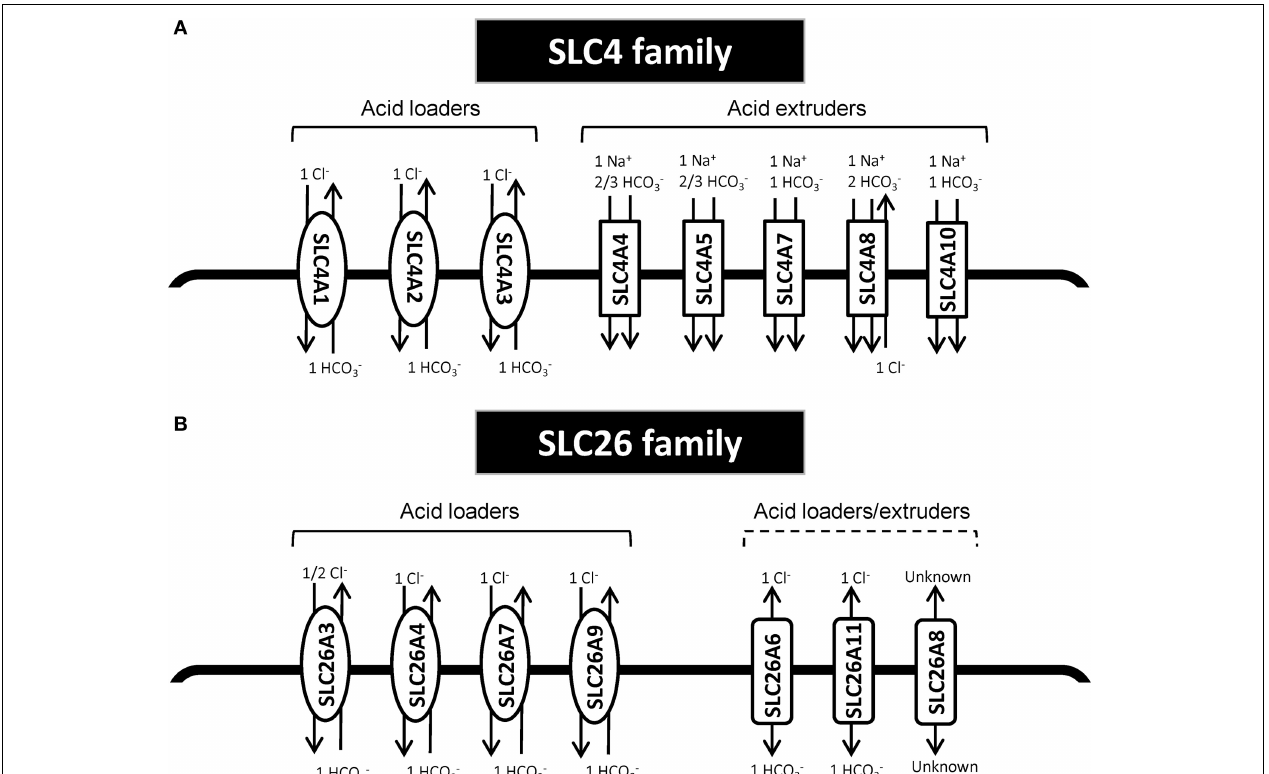
FIGURE 1 | Schematic model of HCO − 3 transporters from the SLC4 and SLC26 family. (A) SLC4 family transporters. (B) SLC26 family transporters. In each panel, the left side shows the acid loaders and the right side shows the acid extruders. It should be noted SLC4A4 in the kidney and SLC4A5 in the choroid plexus are predicted to have a 1Na + :3HCO − 3 stoichiometry and thus